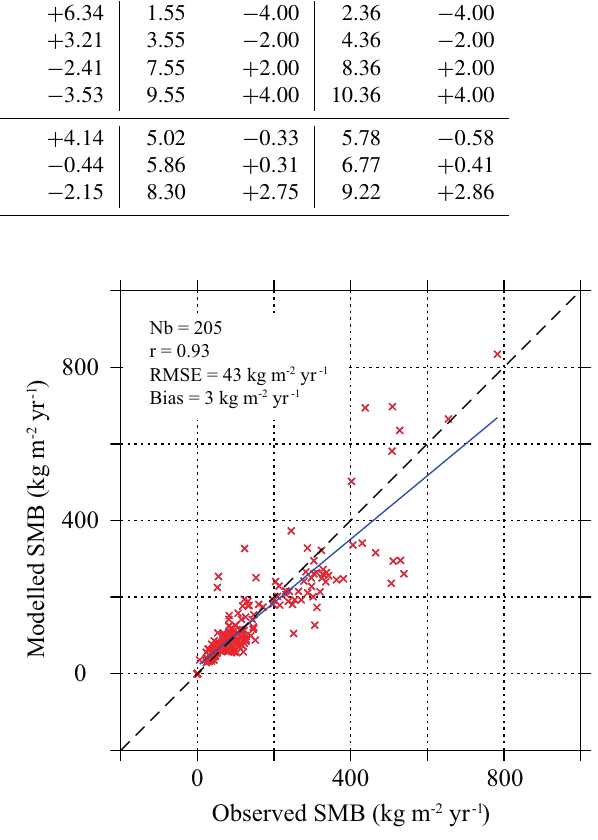
Figure 2. Comparison between MAR SMB and observed SMB from the GLACIOCLIM-SAMBA database (Favier et al., 2013) for 1950–2015. Bias and RMSE units are kgm − 2 yr − 1 . The averaged observation mean is 65kgm − 2 yr − 1